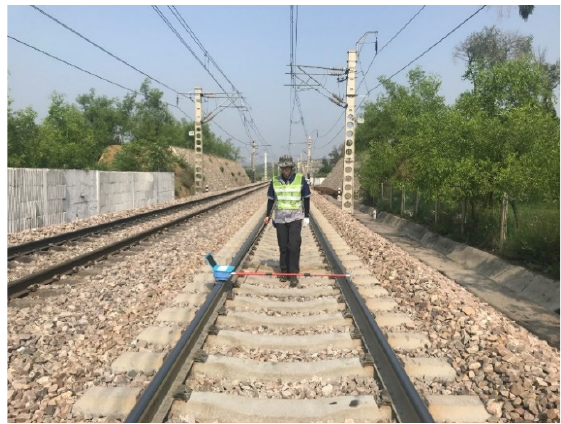
Figure 2. Field test by